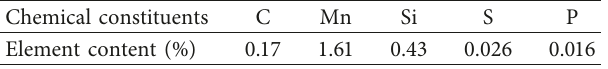
Table 1: Main chemical constituents of the Q355 steel material. Chemical